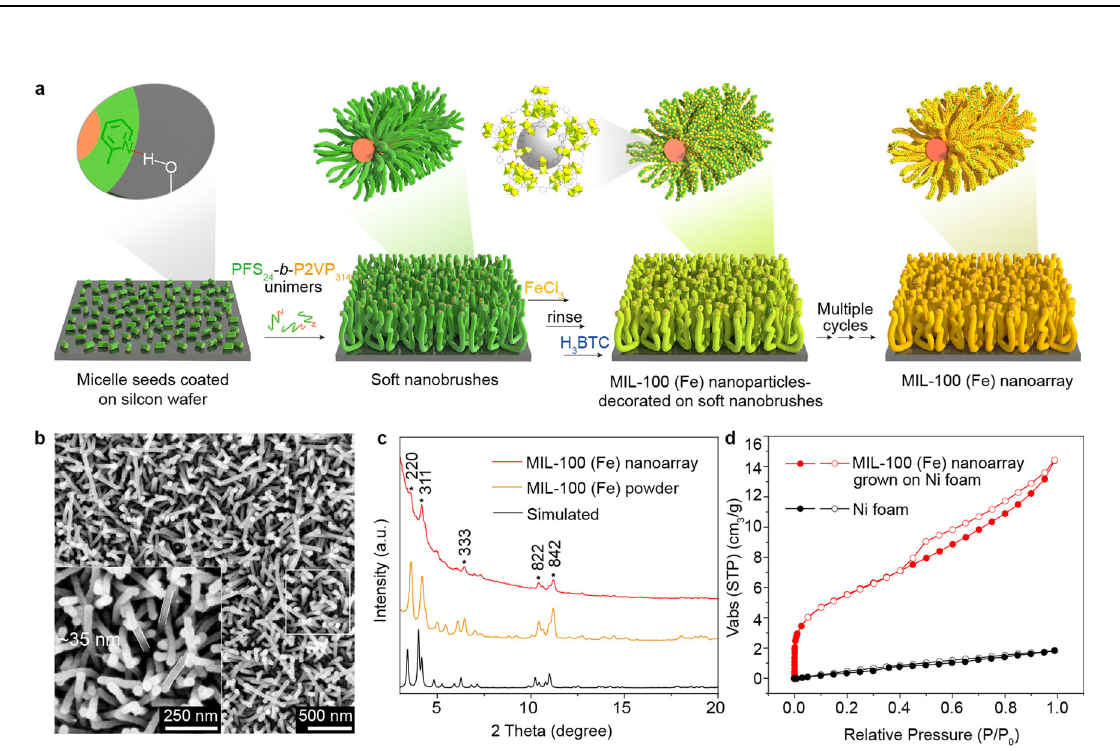
Fig. 2 | Soft nanobrush-directed growth of MIL-100 (Fe) nanoarrays. a Schematicillustrationofthefabricationprocess. b Scanningelectronmicroscope (SEM) images of a nanoarray obtained by alternately immersing a soft nanobrush- coated silicon wafer into ethanol solutions of FeCl 3 and H 3 BTC for fi ve cycles.